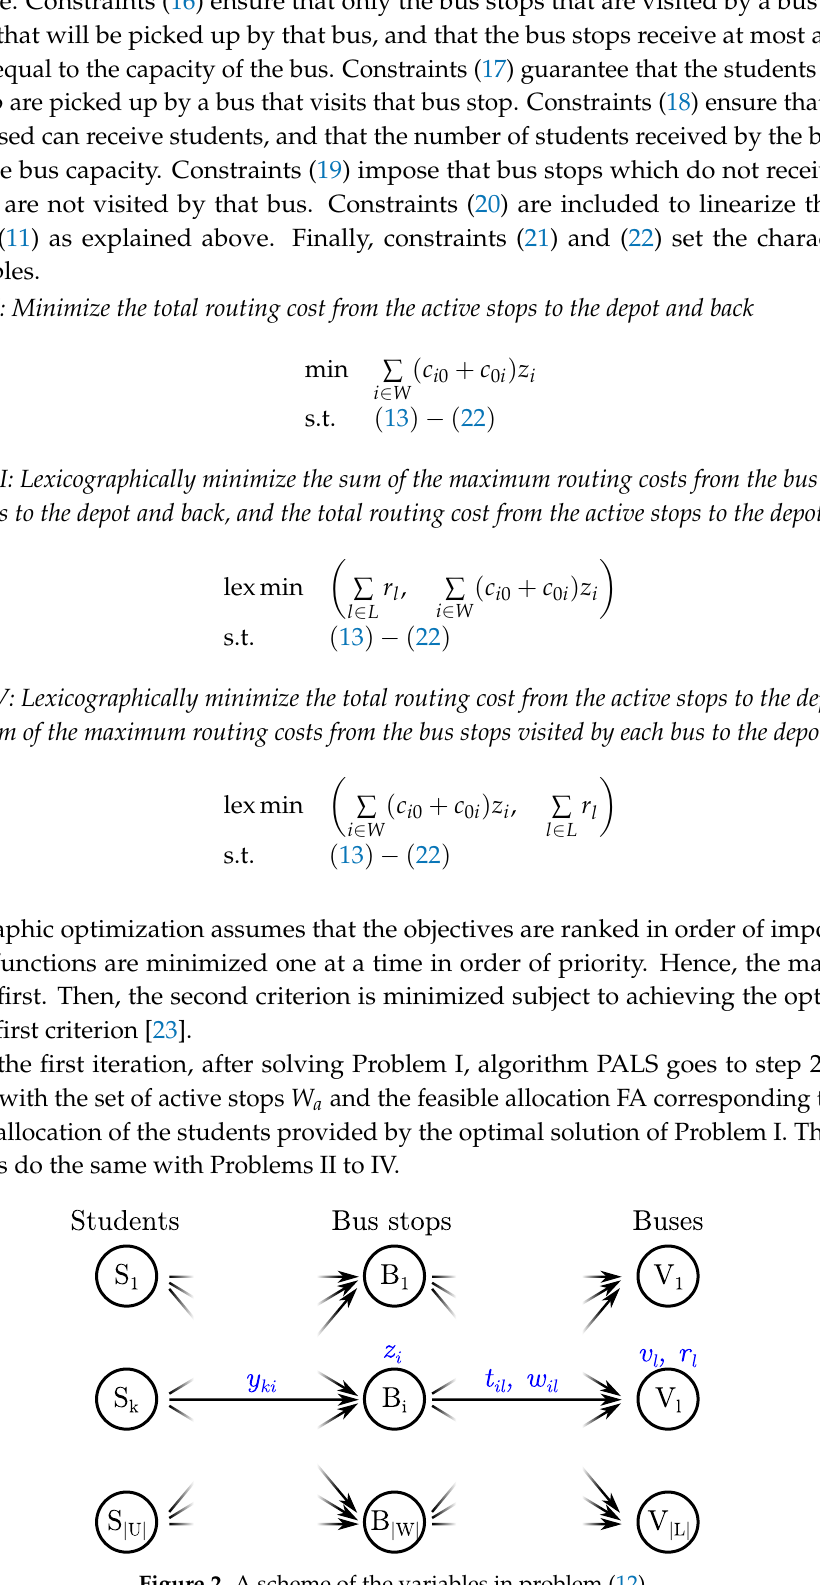
Figure 2. A scheme of the variables in problem